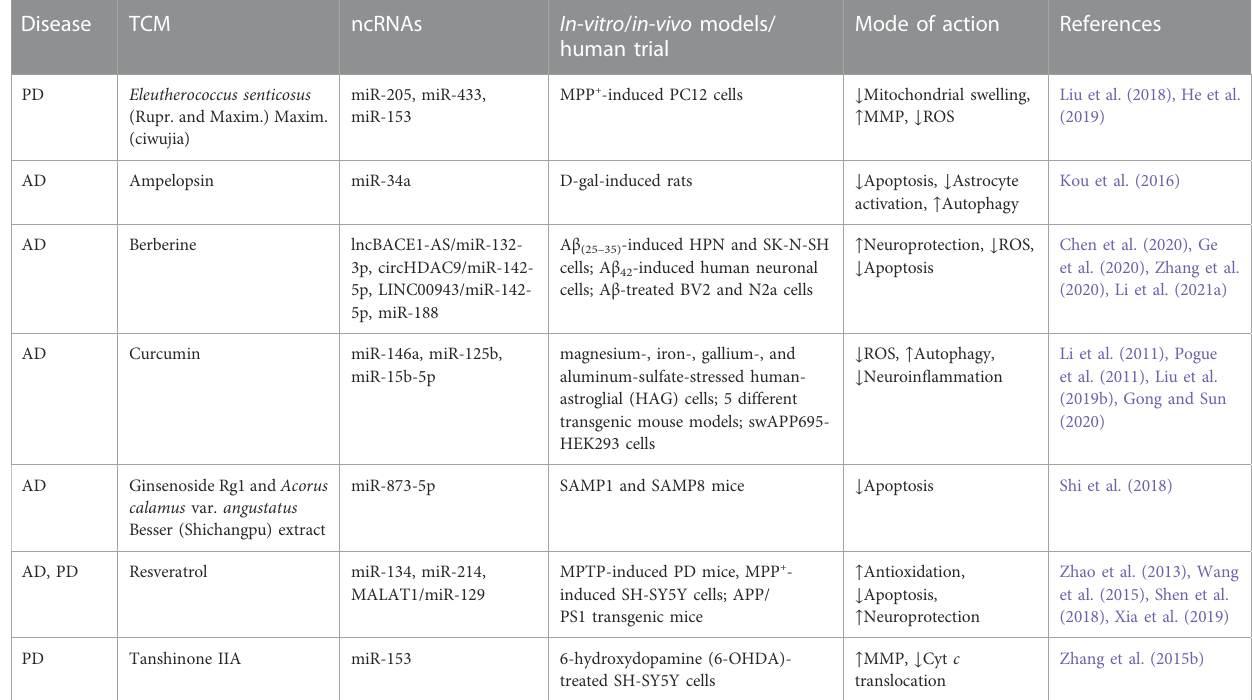
TABLE 4Summaryof traditional Chinese medicines(TCMs)alleviating mitochondrial dysfunction inneurodegenerative diseases (NDs) by modulating non-coding RNAs (ncRNAs).